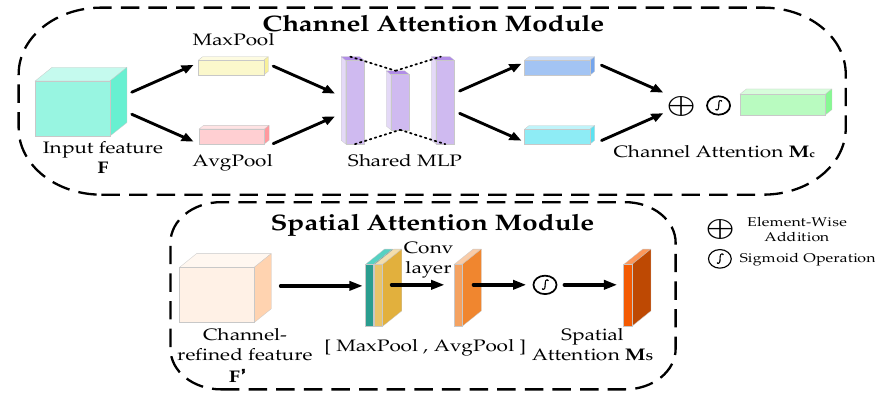
Figure 2. Channel attention and spatial attention in CBAM.